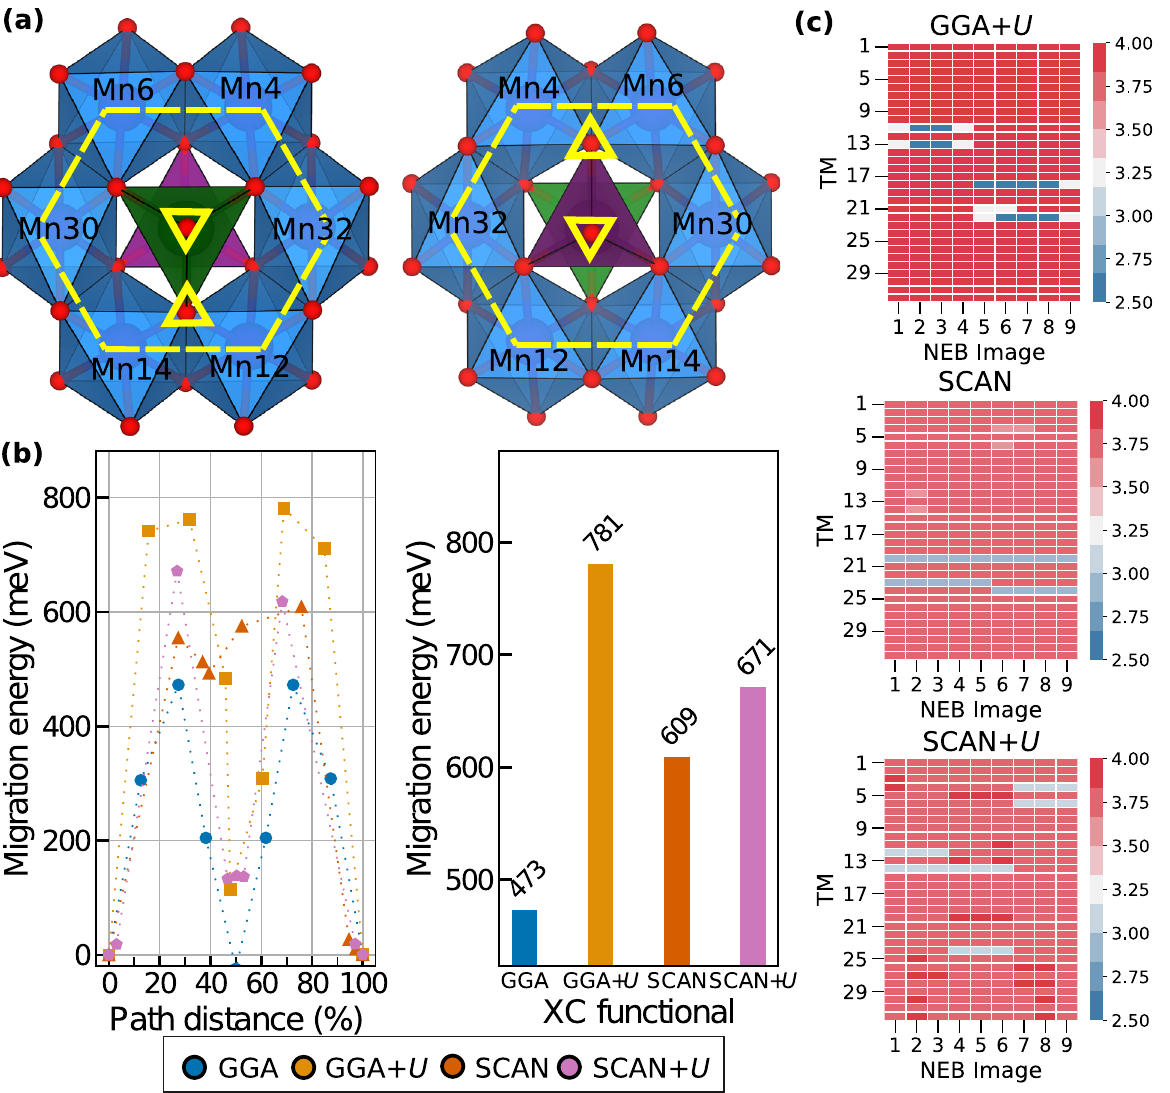
Fig. 5 Migration barriers computed for spinel-MgMn 2 O 4 . a Top and bottom views of the Mn “ ring ” sites (dashed yellow lines) adjacent to the intermediate 16c site during Mg migration. The initial and the fi nal Mg ions are represented by the green and purple tetrahedra, respectively. The yellow triangles represent additional Mn sites (see text for further description). b MEPs and E m . c On-site magnetic moments of Mn ions in the MgMn 2 O 4 structure as a function of image numbers (i.e., as Mg is undergoing migration), where 1st and 9th images correspond to the initial and fi nal Mg sites, respectively. The number indicated on the TM sites in ( c ) is identical to the number indicated in text labels for Mn sites in ( b